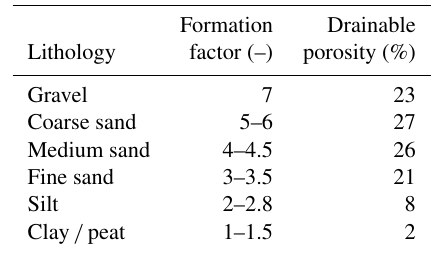
Table 1. Formation factor and drainable porosity for lithology classes. The intrinsic formation factor ( F i ) from literature (De Louw et al., 2011; Faneca Sànchez et al., 2012) and in brackets F i as checked by comparison with TDS–Ec(groundwater) data from Buschman et al. (2008) and An et al. (2014). Drainable porosity based on Johnson (1967).